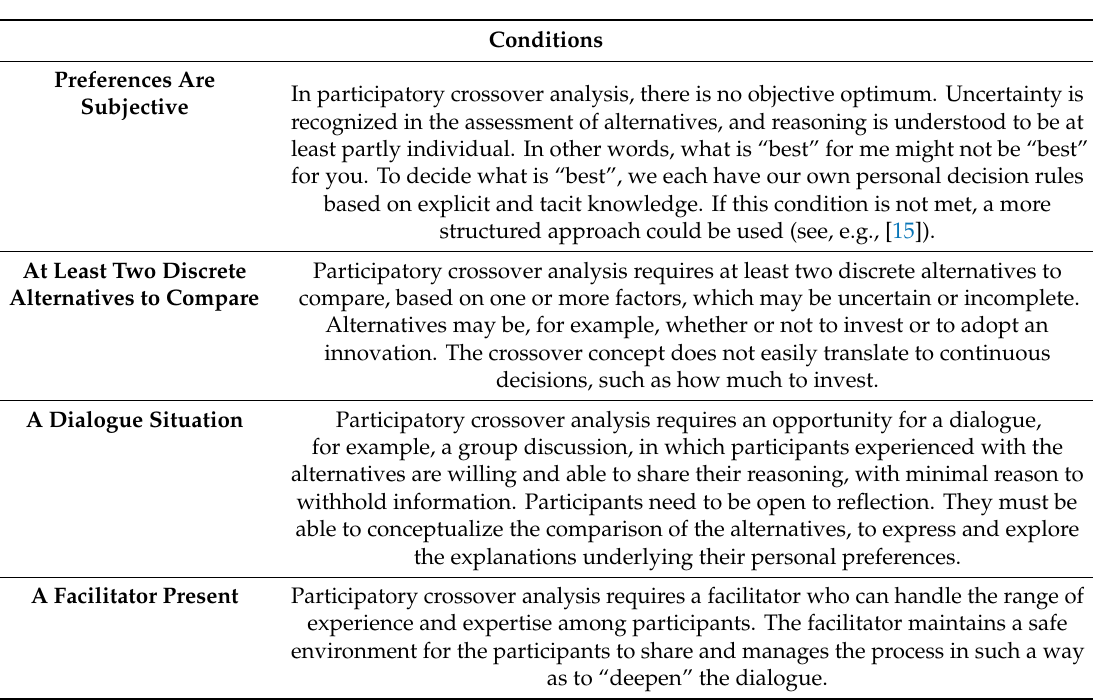
Table 2. Participatory crossover analysis is considered suitable only if ALL of the following conditions are